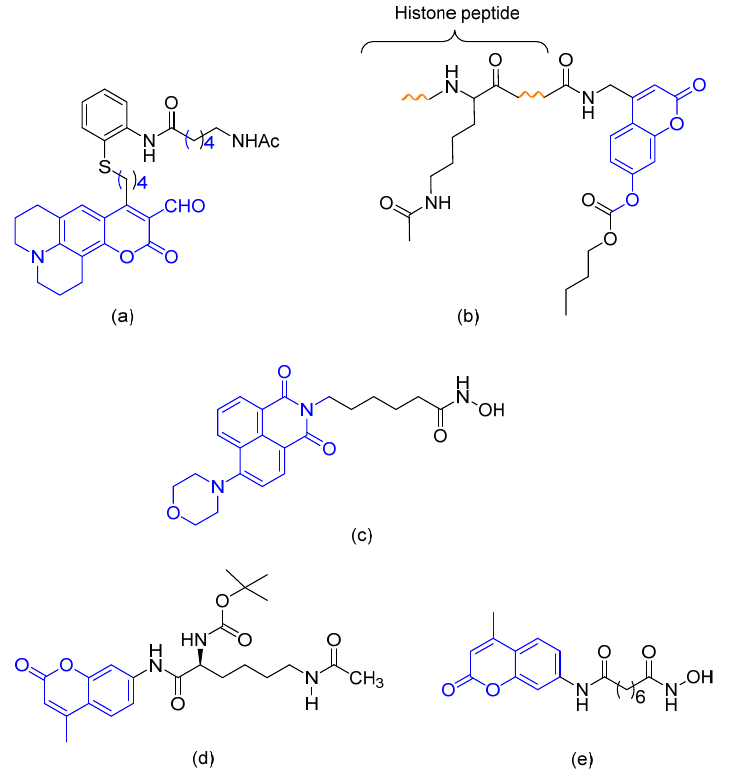
Figure 3. Fluorescent probes for the detection of HDAC activity. ( a ) Coumarin structure for real-time detection of HDAC activity, ( b ) K4(Ac)-CCB structure for monitoring of HDAC activity, ( c ) Scriptaid derivative ( d ) Coumarin probe that can access the catalytic site of HDAC, ( e ) Coumarin-SAHA derivatives.